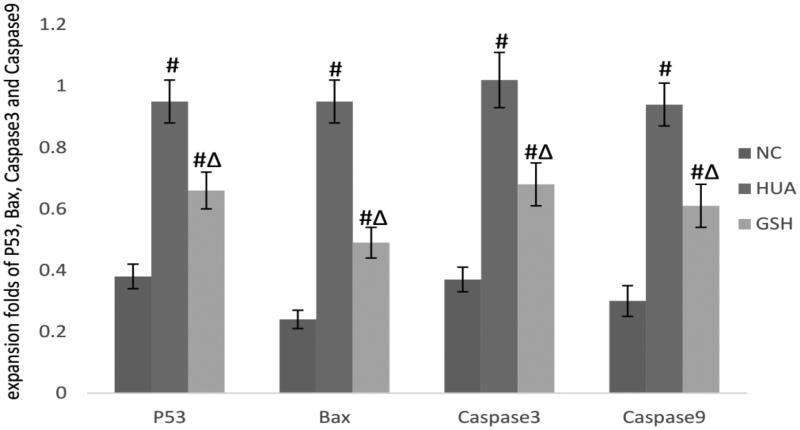
P53: F = 227.438, p = .000; compared with the NC group, #pHUA=.000, #pGSH=.000; compared with the HUA group, ΔpGSH=.000. Bax: F = 492.754, p = .000; compared with the NC group, #pHUA=.000, #pGSH=.000; compared with the DN group, ΔpGSH=.000. Caspase3: F = 210.801, p = .000; compared with the NC group, #pHUA=.000, #pGSH=.000; compared with the HUA group, ΔpGSH=.000. Caspase9: F = 238.550, p = .000; compared with the NC group, #pHUA=.000, #pGSH=.000; compared with the HUA group, ΔpGSH=.000.